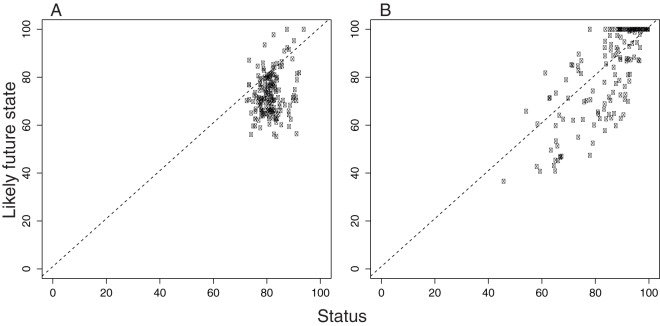
Relationship between current status and likely future state for A) species and B) habitats for all EEZ regions.Dashed line represents a 1:1 positive relationship, with values below this line indicating where the likely future state may be worse than the current state.